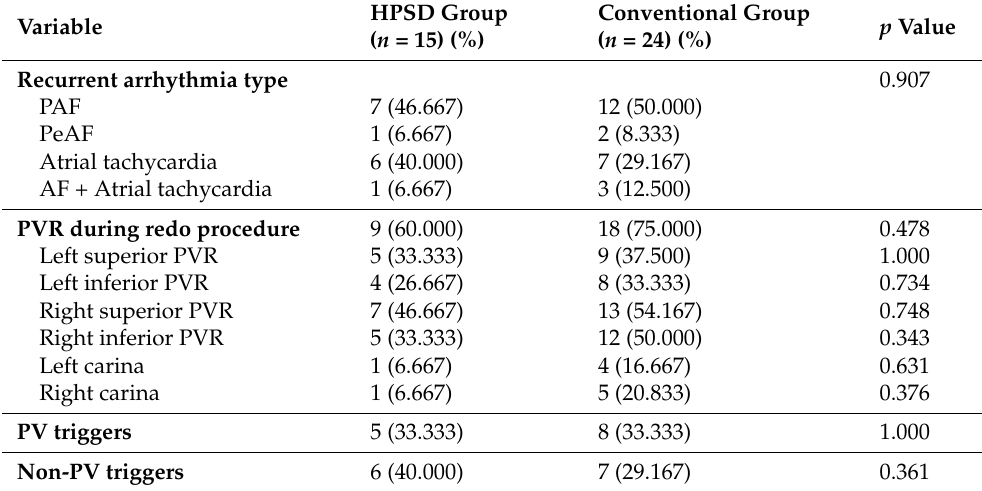
Table 7. Repeat procedure characteristics of recurrent